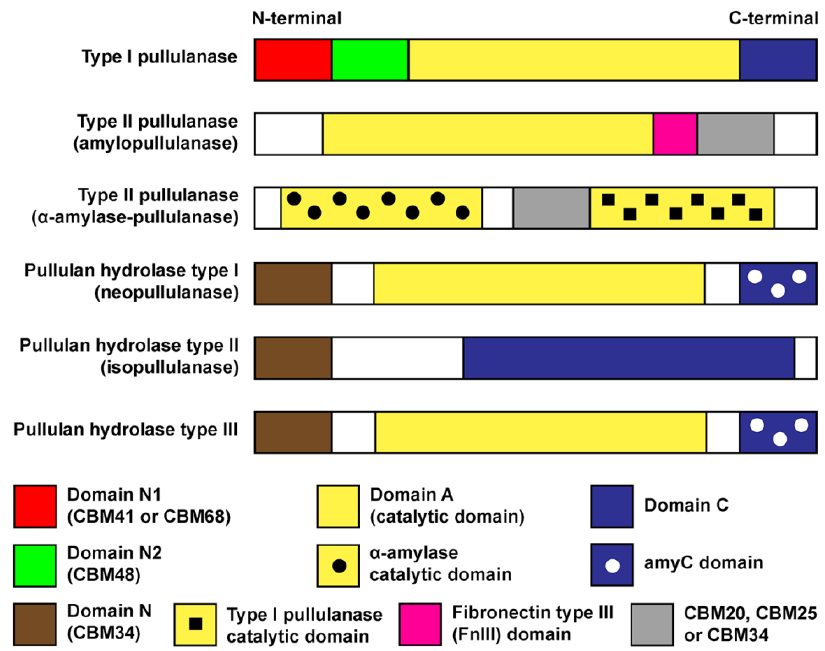
Figure 4. Schematic representation of conserved domains in pullulan-degrading enzymes.